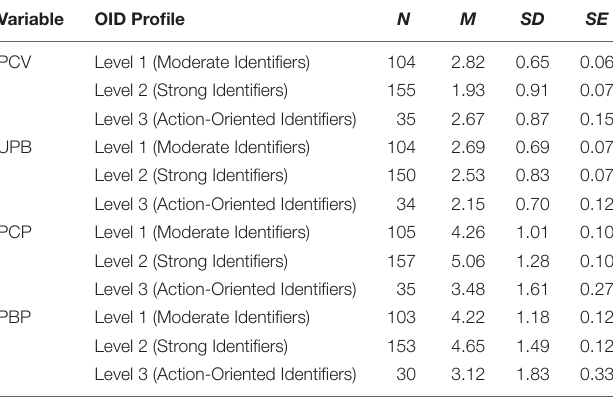
TABLE 13 | Scheffe post hoc tests of mean differences amongst the three OID